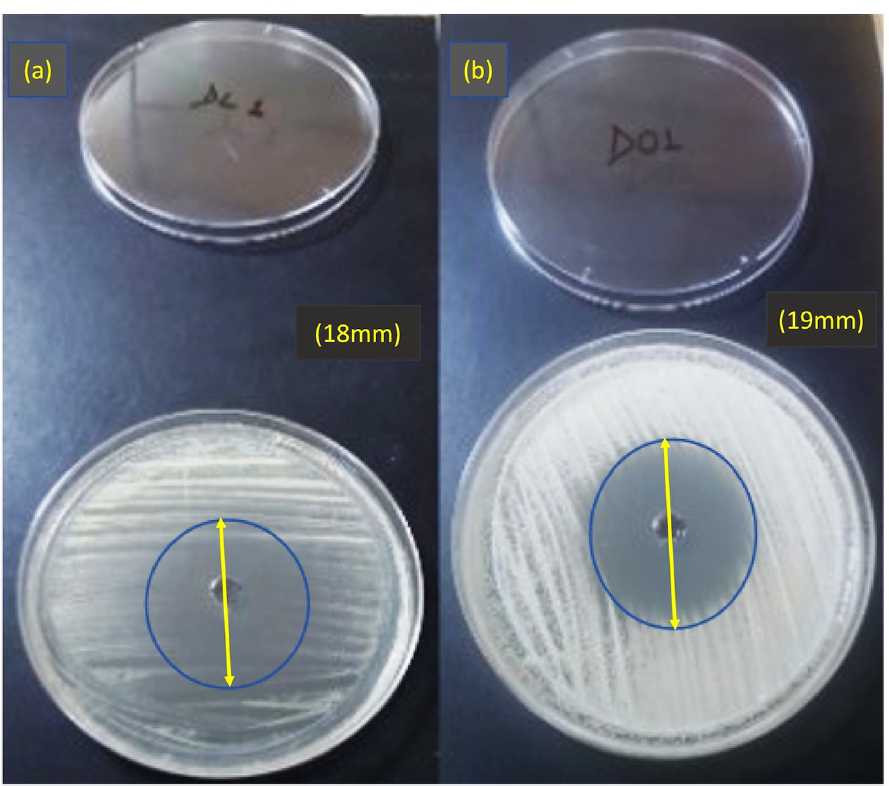
Fig 2. Essential oils screening; Zone of inhibition of chitosan nanoparticles loaded with (a) Lemongrass oil (L) and (b) Oregano oil (O), where the appeared zone of inhibition was 18 mm and 19 mm, respectively.